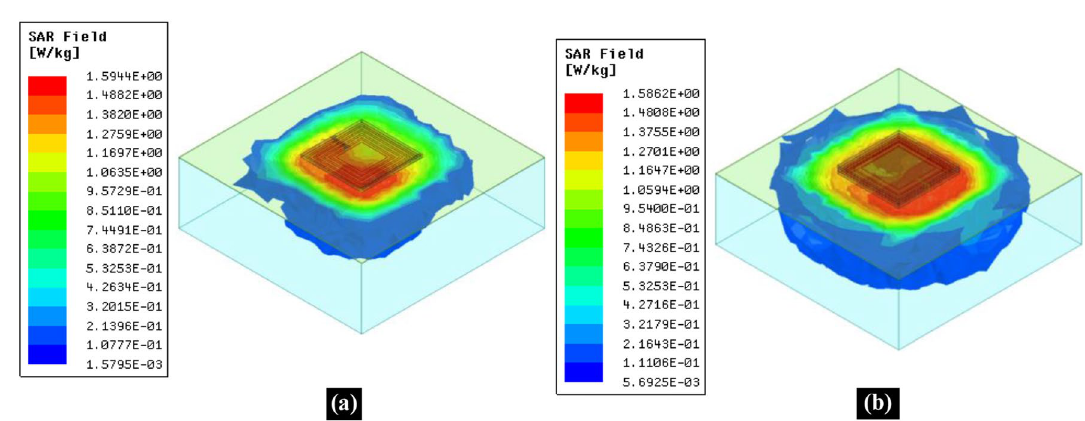
Figure 7. Three-dimensional view of EM Simulated 1-g average SAR distribution at 50 MHz (a) Conventional WPT system with 69 mW of input power. (b) Proposed metamaterial inspired WPT system with 168 mW of input